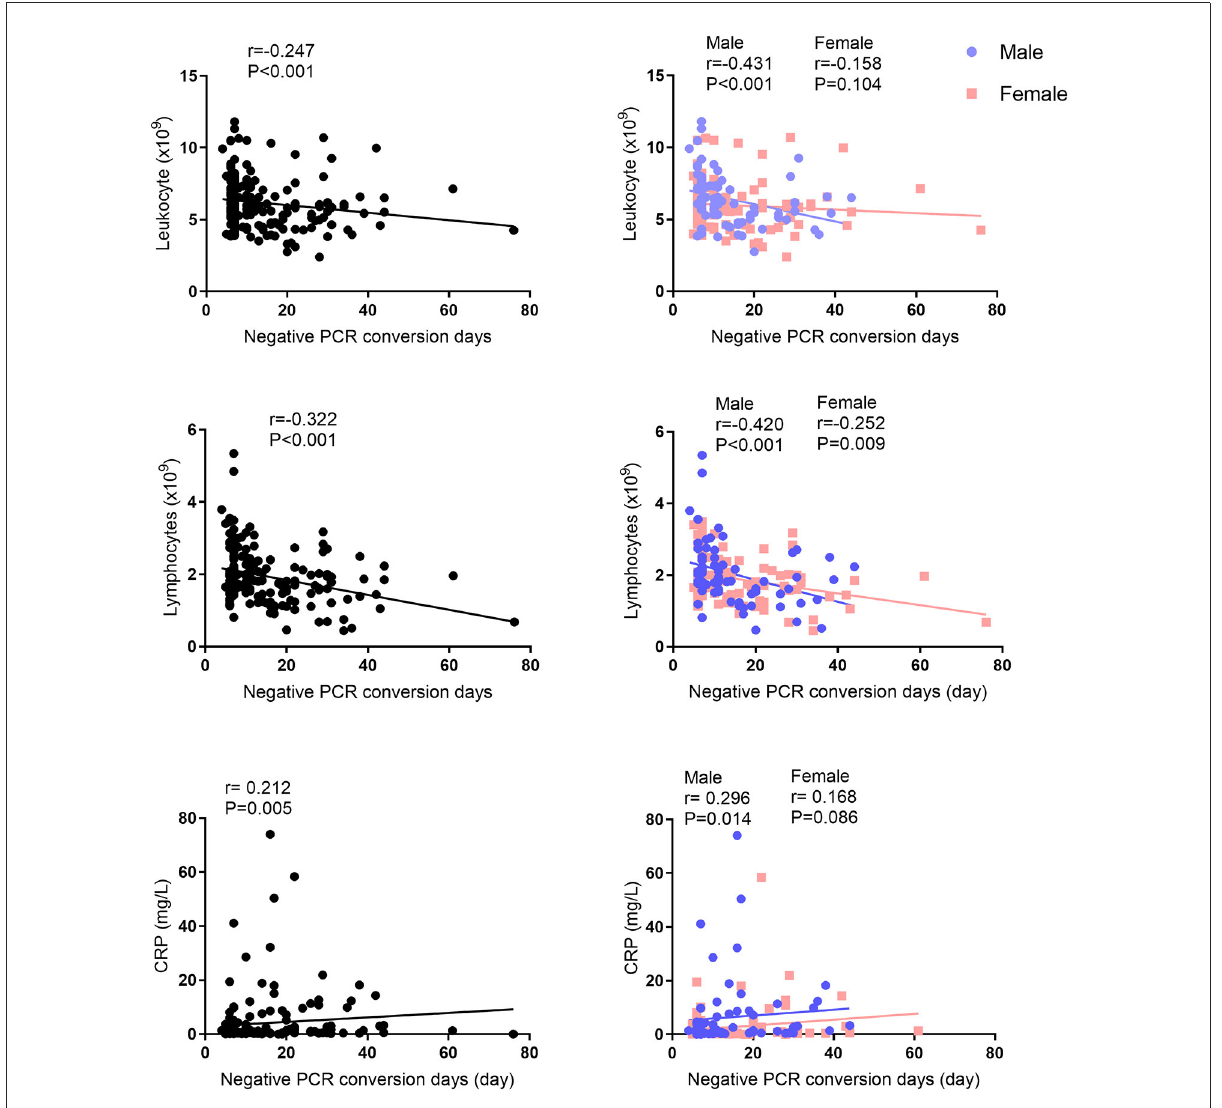
FIGURE2 Correlation analysis between negative PCR conversion days and leukocytes, lymphocytes, or CRP levels.